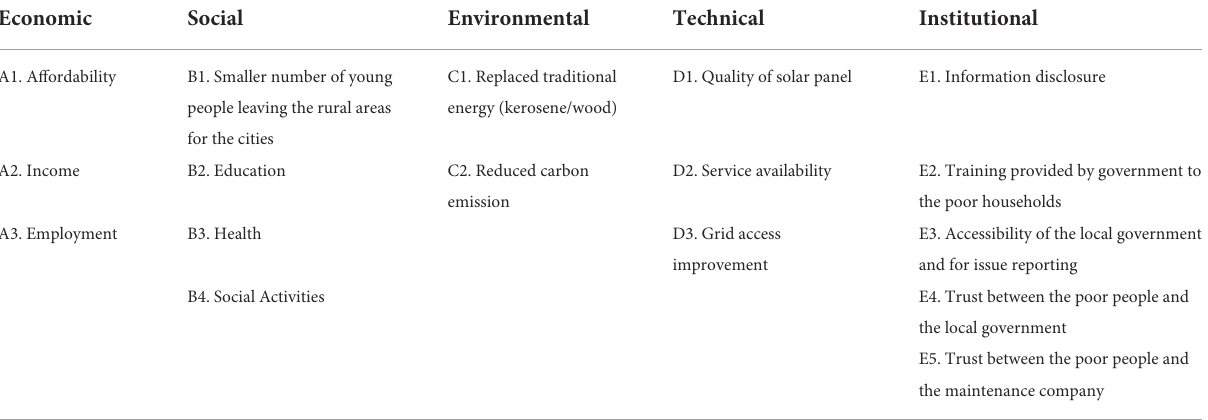
TABLE 1 Sustainability assessment framework (five dimensions and 17